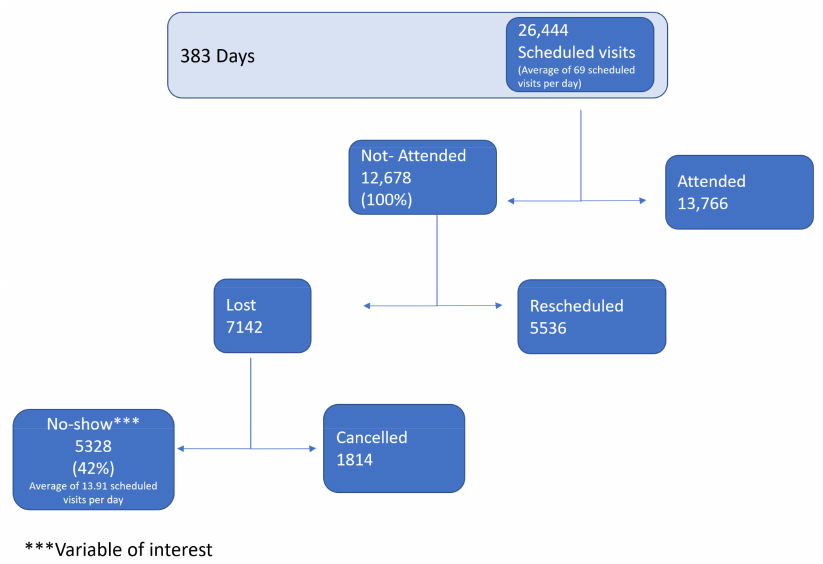
Figure 2. All HIV clinic registry.